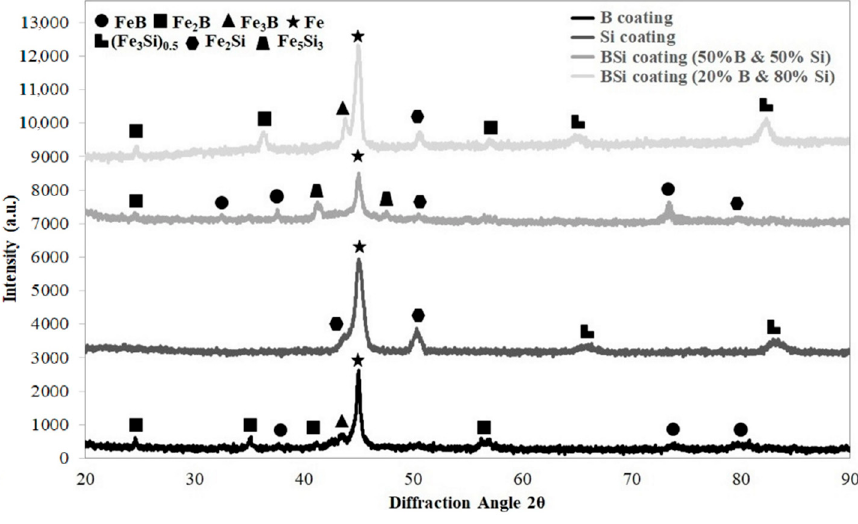
Figure 7. XRD spectrum for coatings produced using laser processing and pre-coat containing boron, silicon and the mixtures of B-Si.